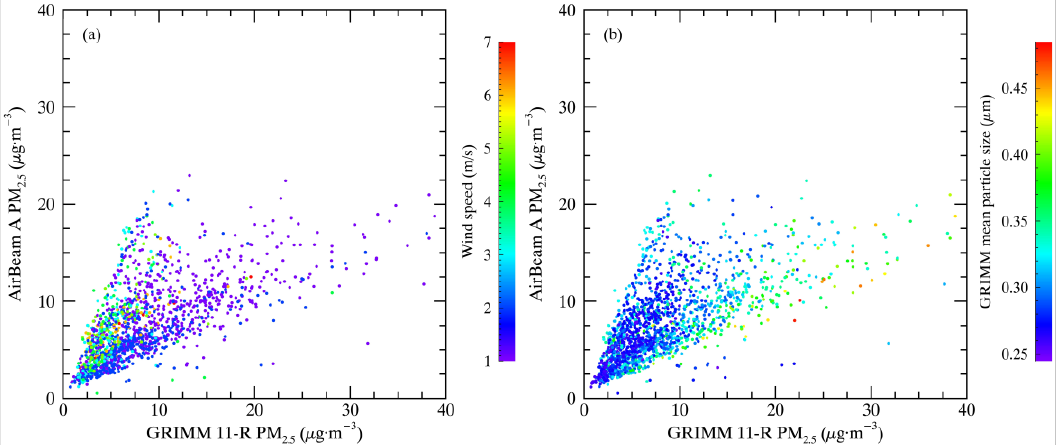
Figure 8. Comparison of GRIMM 11-R- and AirBeam-derived PM 2.5 . Color coding shows wind direction ( a ) and GRIMM 11-R average particle size ( b ).